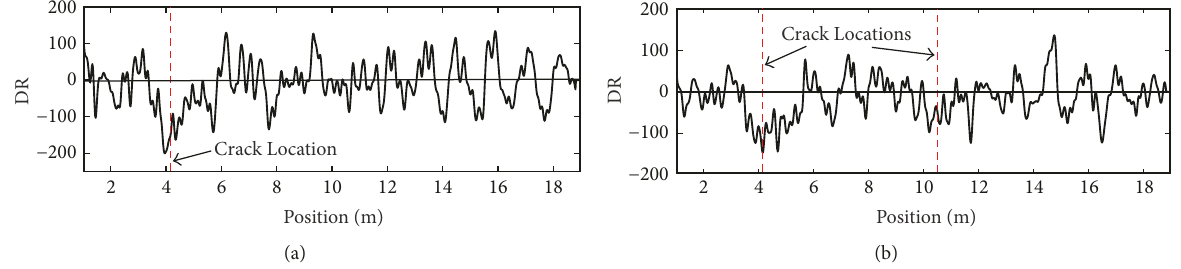
Figure 14: The first damage indicator in presence of noise: (a) the first damage case and (b) the second damage case.